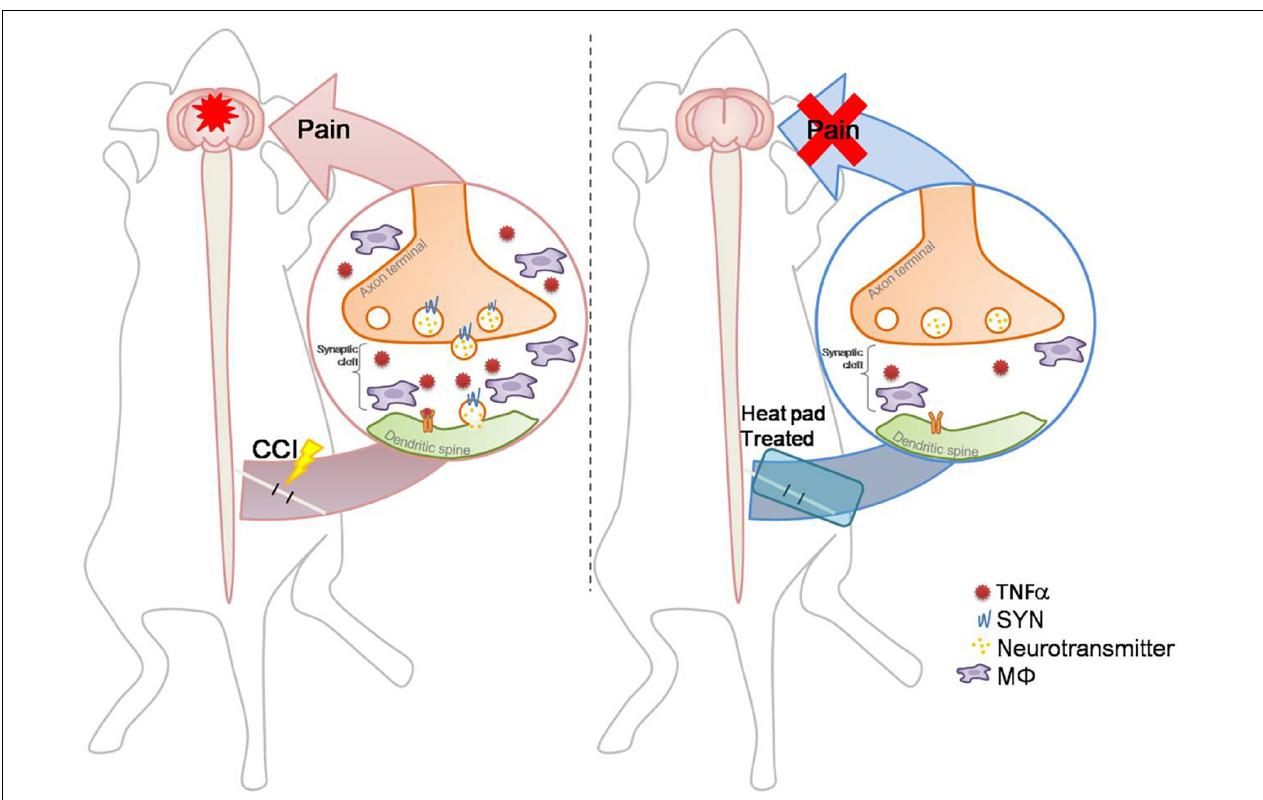
FIGURE 7 | Schematic diagram: a conditional hot compress regulates the crosstalk between the inflammatory factors and synaptic transmission signals. The CCI-induced nerve injury increases TNF α and Syn levels and increases immune cell infiltration. The hot compress inhibits inflammatory factors and Syn to attenuate mechanical allodynia and abnormal electrophysiological responses, and exerts an effective analgesic effect on CCI-induced neuropathic pain through neuroendocrine cells to the brain mediation for inhibiting sciatic nerve